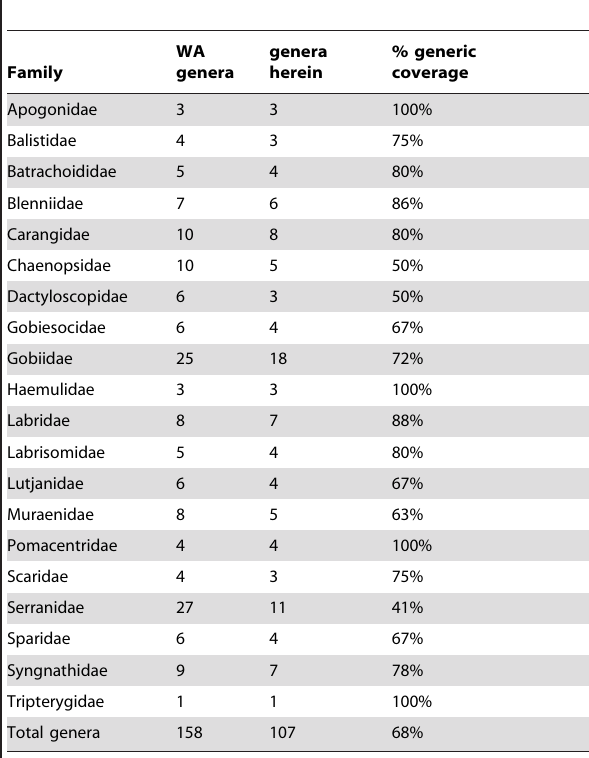
Table 2. Coverage reported here of the speciose fish families listed by Floeter et al. [42] for the Western Atlantic